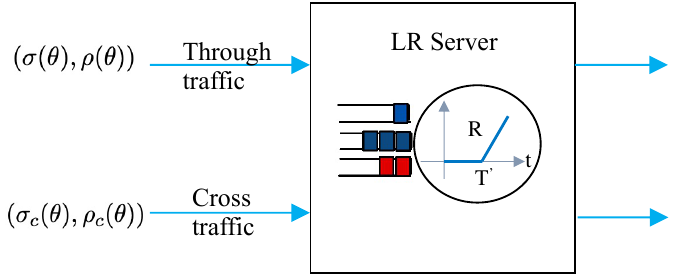
Figure 2. Traffic model of a single node.